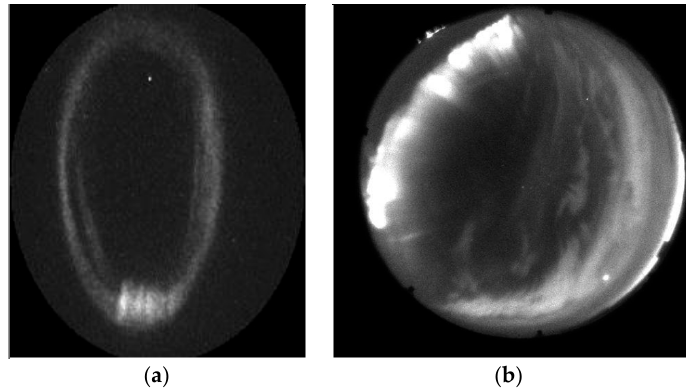
Figure 1. Aurora images. ( a ) Aurora images captured by ultraviolet imager (UVI). ( b ) Aurora images captured by all-sky imagers (ASI).